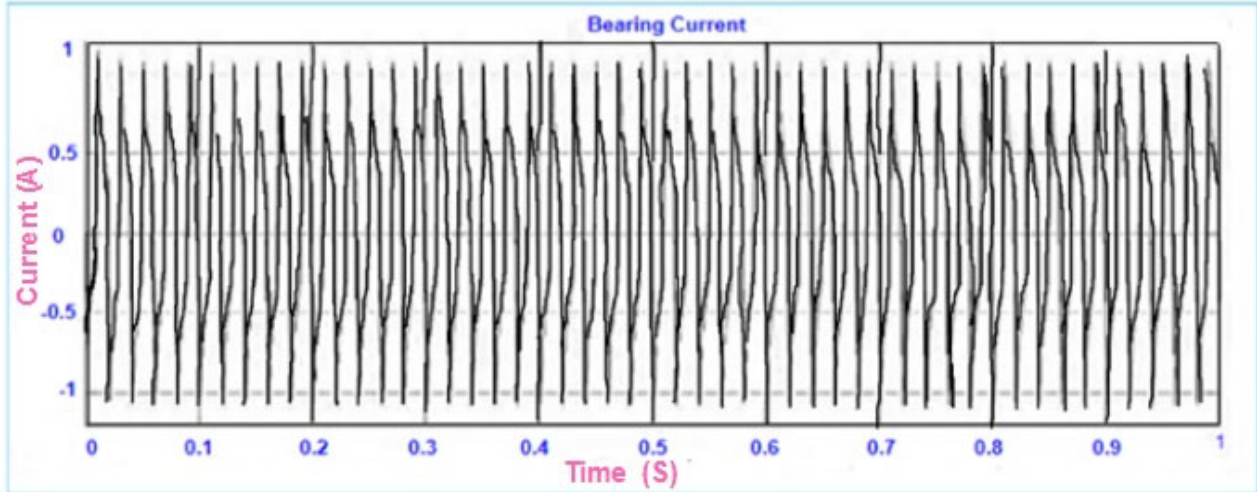
Figure 24. CBC of modified ANN ‐ based sensorless induction motor with T ‐ bridge inverter.